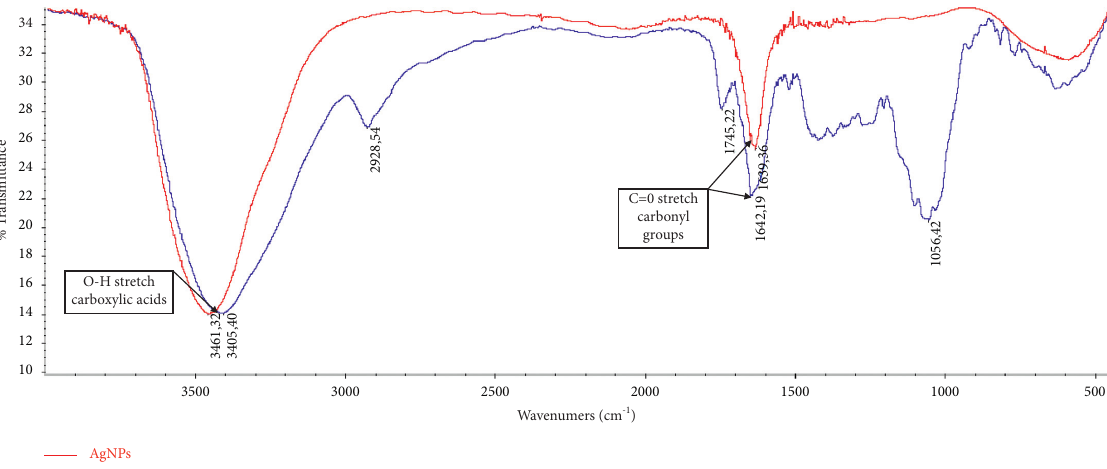
Figure 3: Fourier transform infrared spectroscopy (FTIR) analysis of biosynthesized silver nanoparticles (AgNPs) and the aqueous extracts of orange